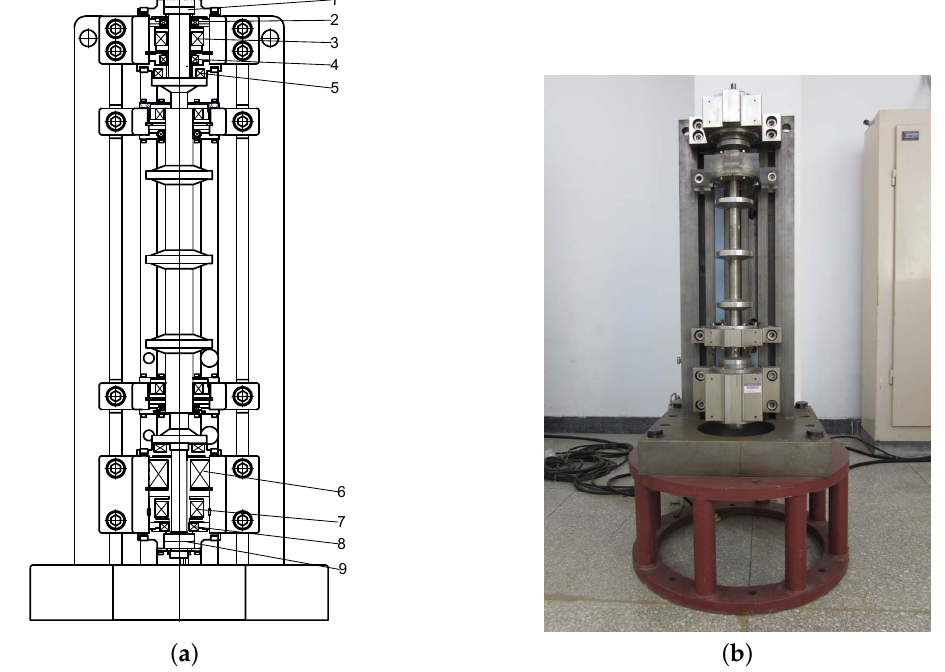
Figure 10. The rig of the AMB–rotor system used for experiments. ( a ) Structure: 1, upper auxiliary bearing; 2, upper radial sensors; 3, upper radial AMB; 4, axial sensor; 5, axial AMB; 6, electric motor; 7, lower radial AMB; 8, lower radial sensors; 9, lower auxiliary bearing. ( b ) Test